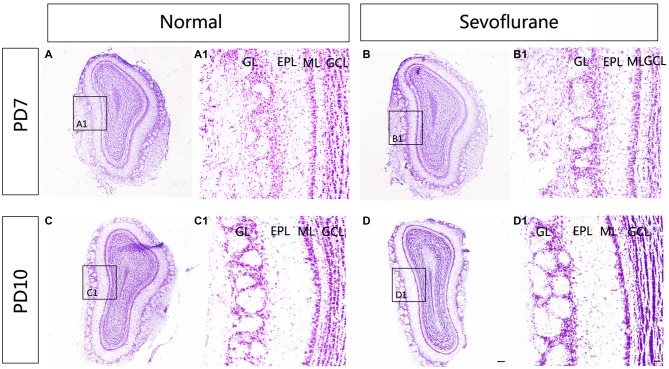
The effect of exposure to sevoflurane at postnatal days 7 (PD7) and 10 (PD10) on the laminar organization of main olfactory bulb (MOB). No significant change in the laminar organization of the MOB was observed between control mice (A) and mice exposed to sevoflurane at PD7 (B). Compared to control MOBs (C), the laminar organization of the MOB in mice that were treated with sevoflurane at PD10 (D) was unchanged. (A1–D1) High magnification images showing the structure of the MOB. Scale bars = 500 μm in (D) (applies to A–D) and 100 μm in (D1) (applies to A1–D1).